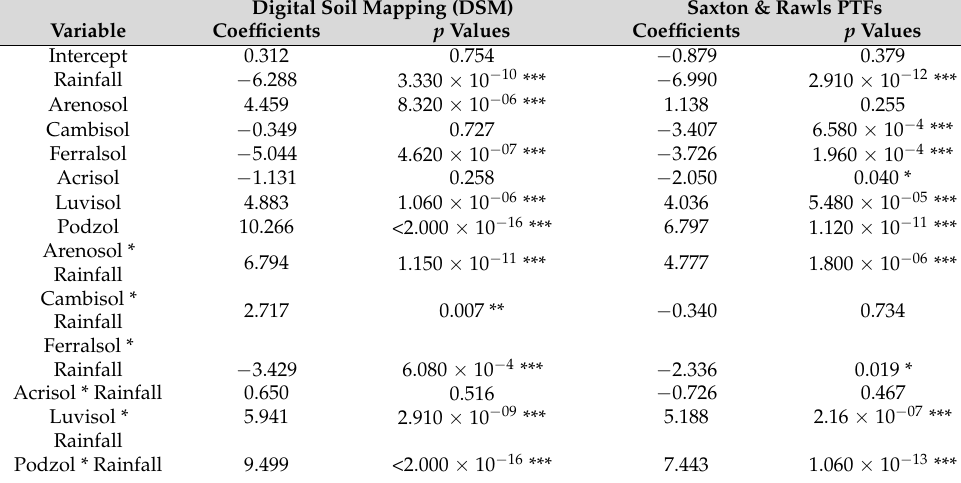
Figure 4. The root mean squared error (RMSE) and Coefficients of determination (R 2 ) obtained by comparing the MODIS CC time series (as observed on the x -axis) with either the DSM (orange dots) and the Saxton (black crosses) CC time series (as simulated on the y -axis) for the 12 land units for a simulation period of (2002–2012). Table 3. Intercepts, coefficients, and p values for the ANOCOVA tests based on Equation